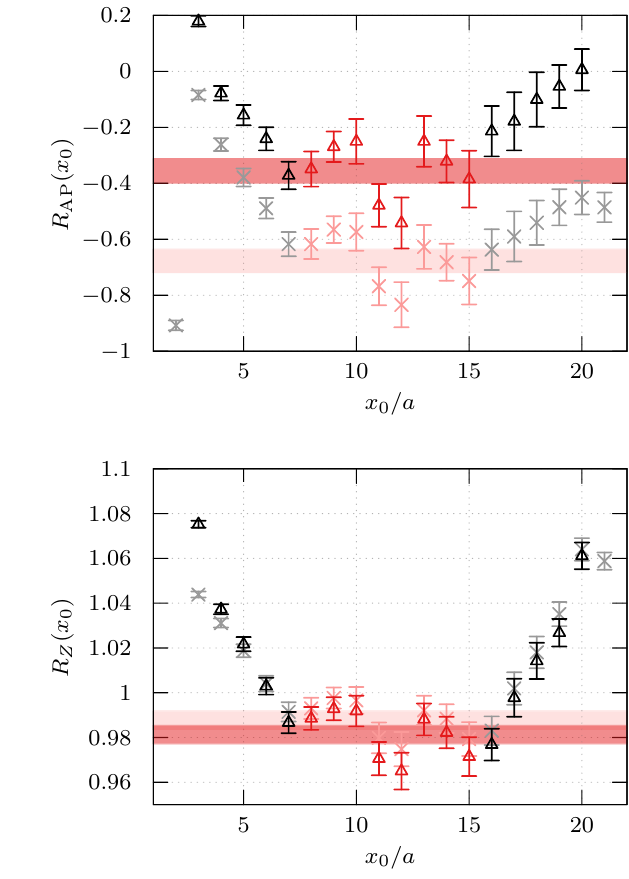
Fig. 9 ResultsfortheensembleB1k4andvalencequarkswithhopping parameter κ 2 = 0 . 13594, corresponding to L (cid:6) 22 ≈ 0 . 5. Top left panel: PCAC mass Lm 22 ; the red points of the central third of the time exten- sion are averaged to give the plateau, drawn as a red band. The points in the background with lighter colours (crosses) correspond to the result